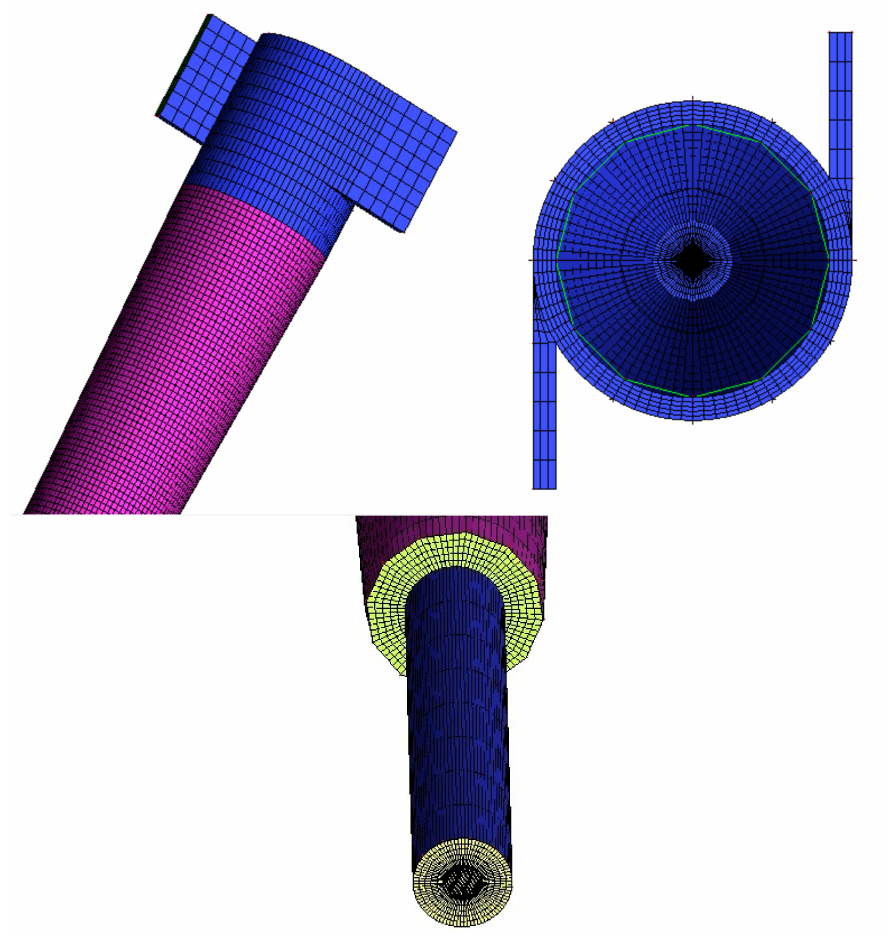
Figure 2. The numerical mesh used in this